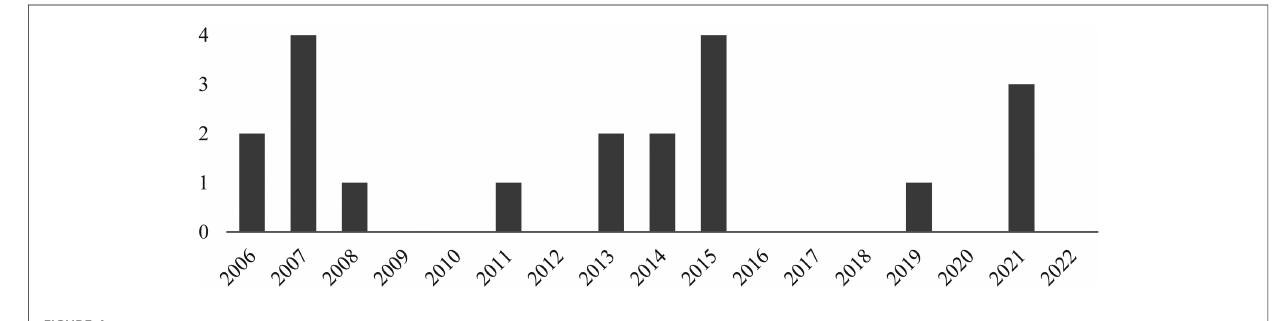
FIGURE 4 Chart of detect MH cases per year from 2006 to 2022 at the authors ’ institution. A yearly rate of 0 to 4 patients with MH was noted.